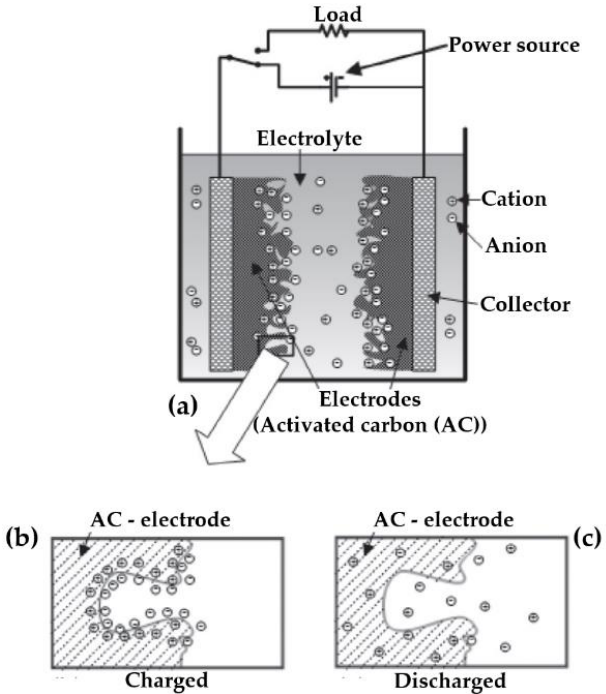
Figure 2. The EDLC formed by a collector, AC electrodes, and an electrolyte: ( a ) concept, ( b ) charging, ( c ) and discharging [18].